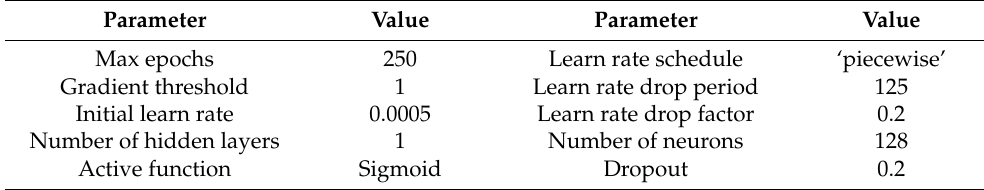
Table 1. GRU model parameters.